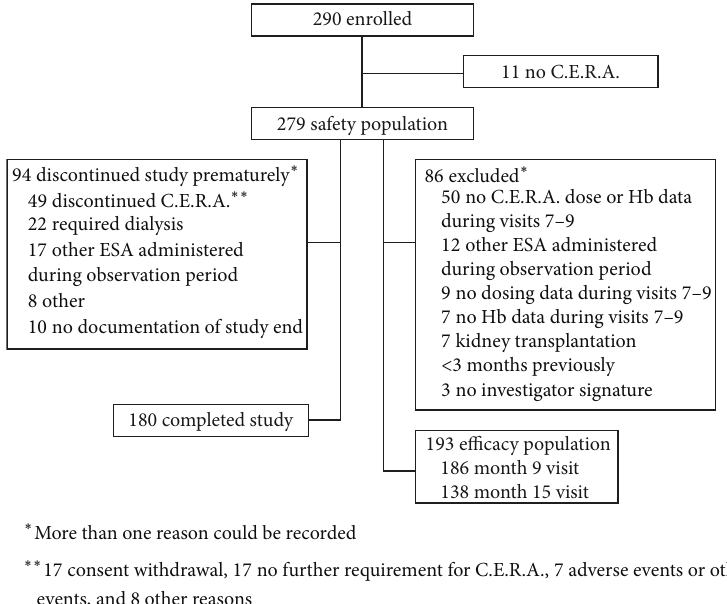
Figure 1: Patient